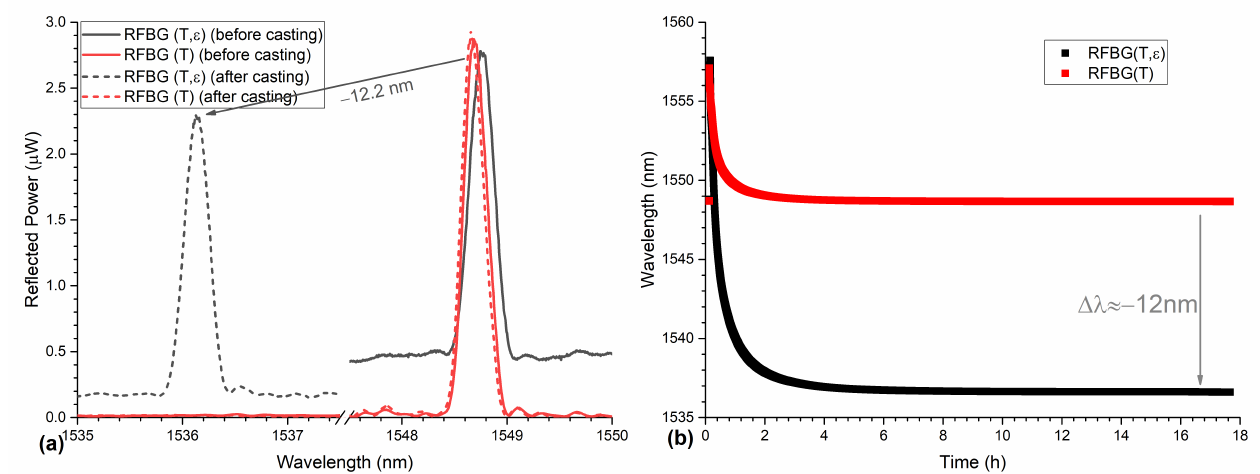
Figure 11. ( a ) Spectra of the RFBGs before and after casting at room temperature. The spectra of the temperature sensor (RFBG(T)) before (solid red line) and after casting (dashed red line) are superimposed, indicating no drift of the sensor occurred during the casting process. ( b ) Wavelengths of the RFBGs during the casting of the aluminum. The wavelength of both RFBGs increased at the beginning followed by the cooling of aluminum. The Wavelength of the temperature sensor went back to the starting wavelength and the strain sensor shifted ∼ 12.2nm towards lower wavelengths due to thermal shrinkage of the